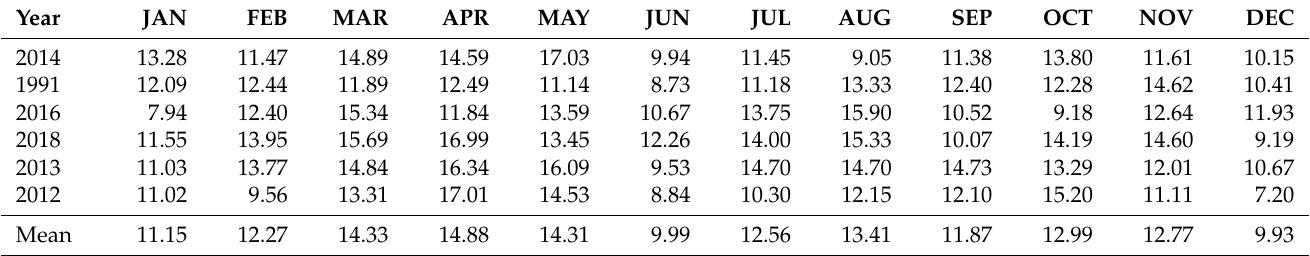
Table 8. Monthly solar power generation load factor (%) using the irradiance of the representative